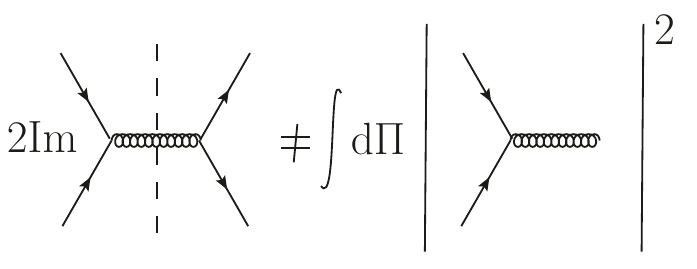
Figure 2 . Breakdown of the optical theorem in the GSGh